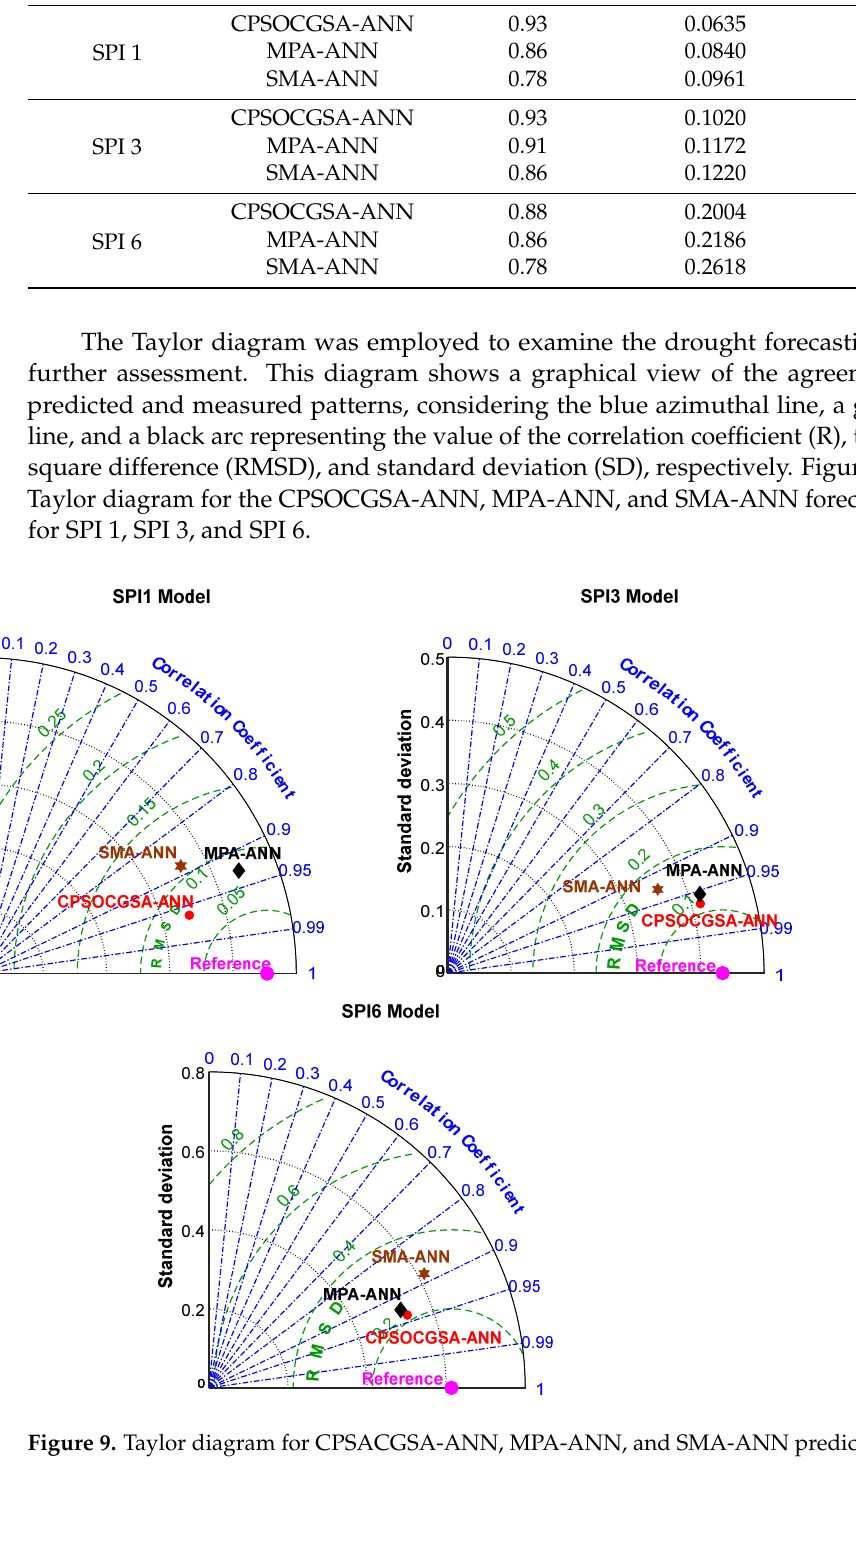
Table 5. Performance assessment criteria for CPSOCGSA, MPA, and SMA in the validation stage. Target